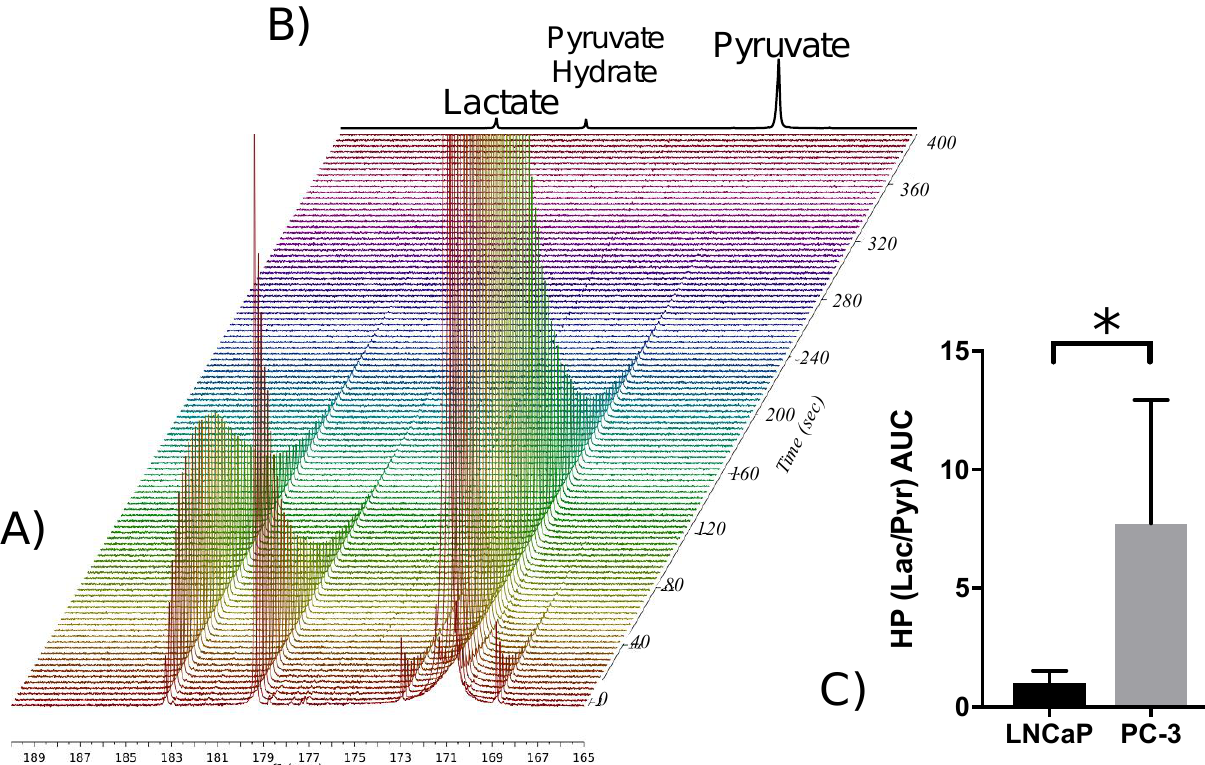
Figure 8. Increased glycolytic activity of CRPC is measured in real-time using HP [1- 13 C]pyruvate. ( A ) Representative dynamic spectra of hyperpolarized [1- 13 C] pyruvate being converted to [1-13C] lactate in PC-3 cells. ( B ) summed HP 13 C spectra show the lactate signal that arises from [1- 13 C]pyruvate. ( C ) Mean HP (Lac/Pyr) area under the curve (AUC) (* p < 0.05, n = 4).